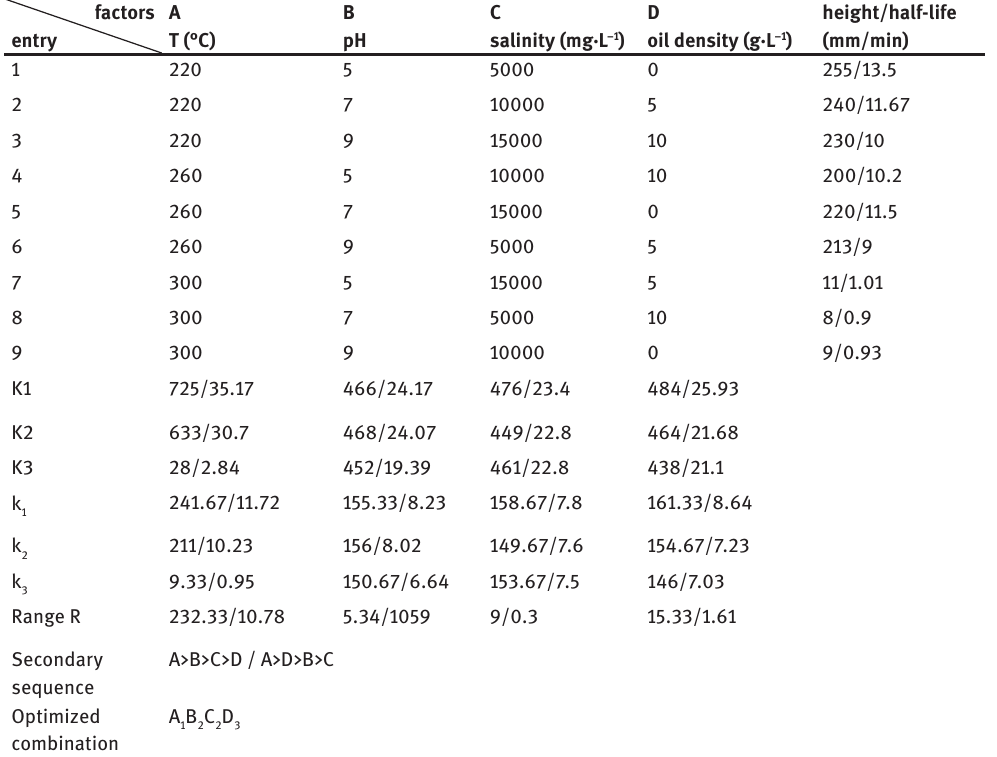
Table 1: Orthogonal experimental data for foam height and half-life.